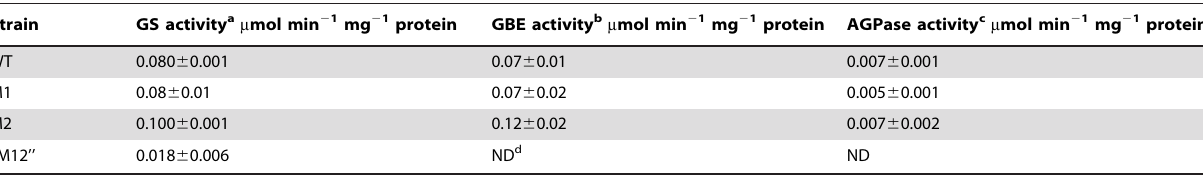
Table 2. Effects of insertional mutation of sll 1393 and sll 0945 genes on GS, GBE, and AGPase activities.